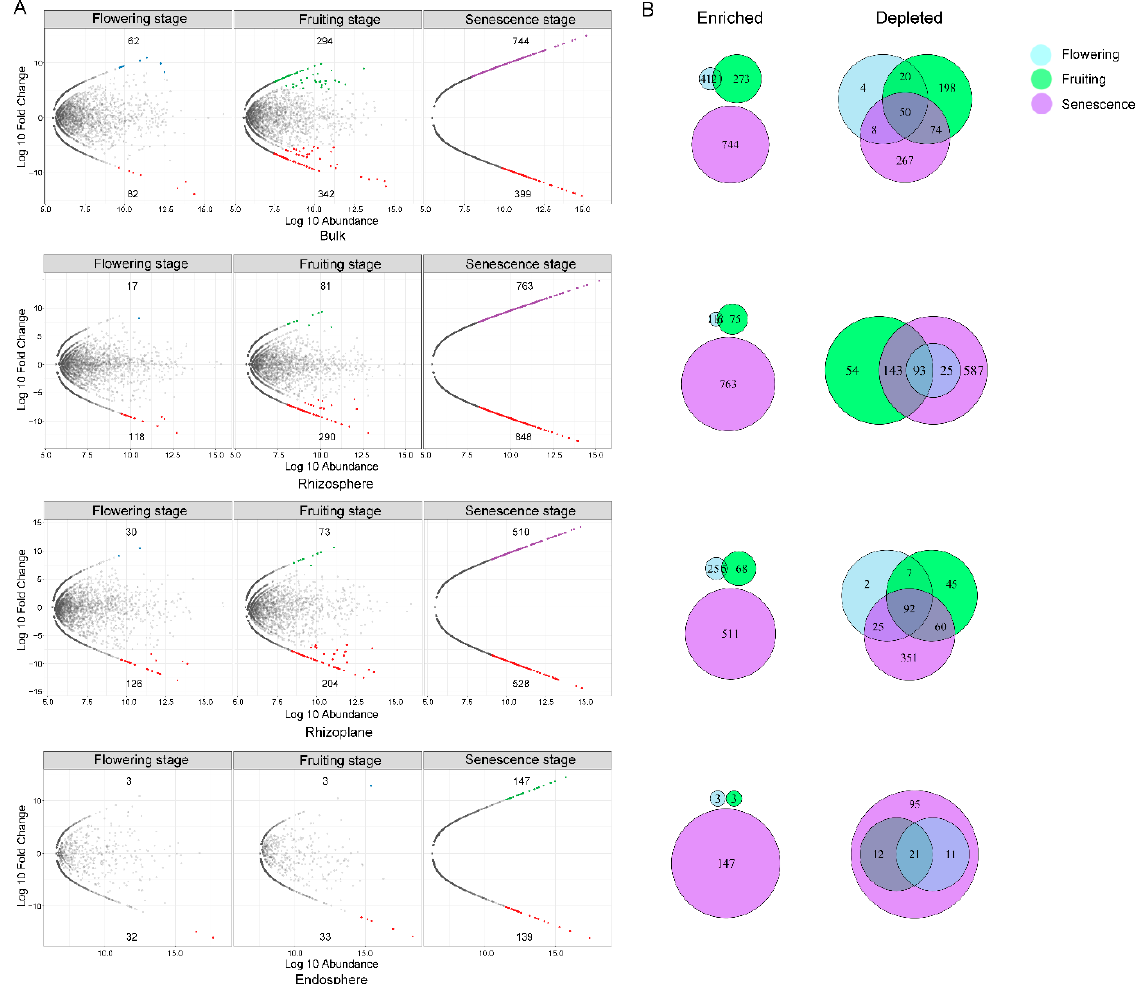
Figure 8. Bacterial community comparison between the four growth stages in each root-associated compartment. ( A ) MA diagrams showing the enrichment and depletion of 16S OTUs for each growth stage (flowering stage, fruiting stage, and senescence stages) compared with the vegetative stage in three rhizocompartments. Each point represents an individual OTU, of which the blue, green, and purple points represent enriched OTUs in the flowering stage, fruiting stage, and senescence stages compared to the vegetative stage, while the red ones indicate the depleted OTUs, and the grey points represent no difference in abundance. The position along the y-axis represents the abundance fold change compared with the bulk soil. ( B ) Venn diagrams illustrating the numbers of differentially enriched and depleted OTUs between each stage compared with the vegetative